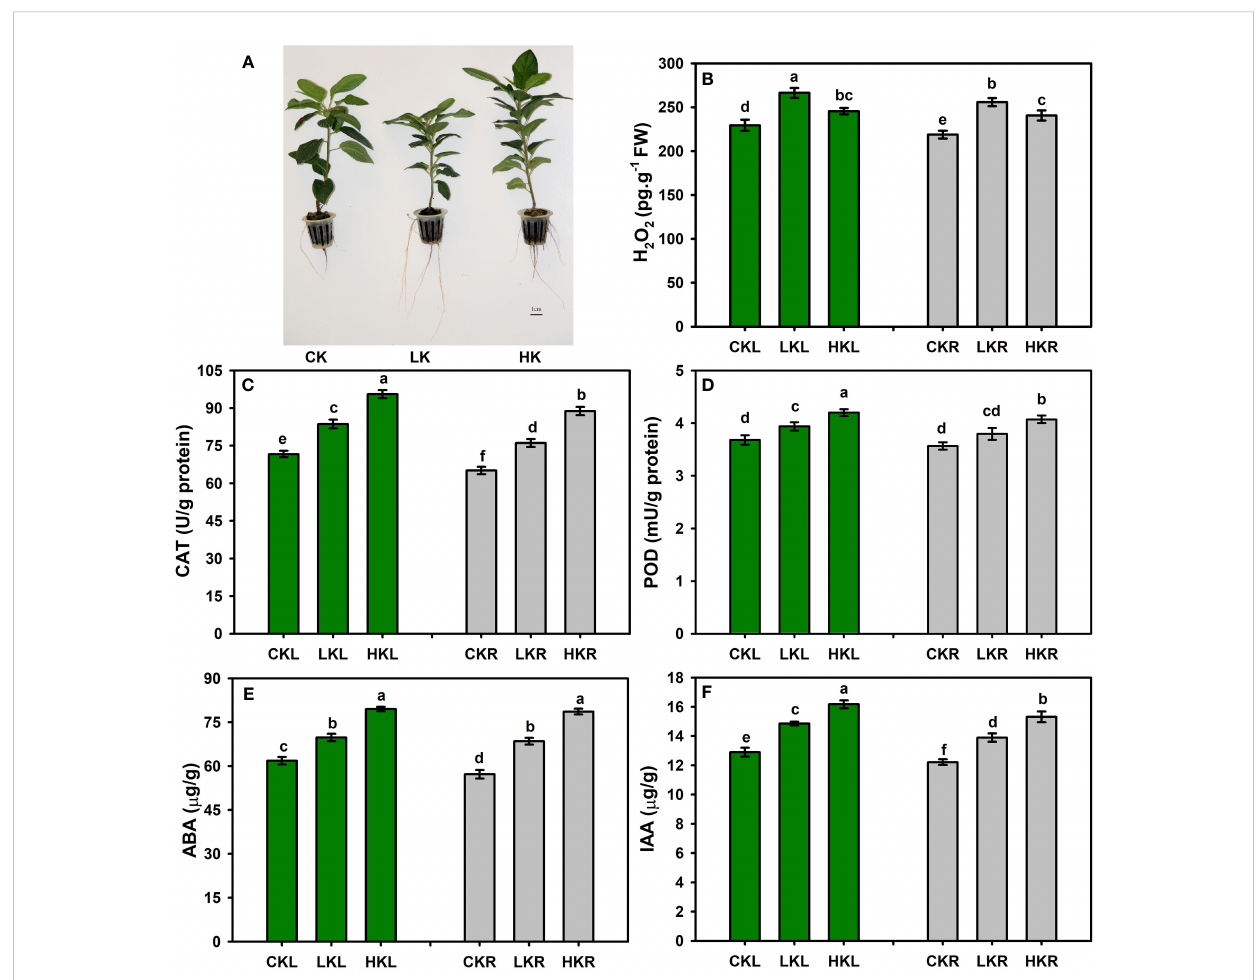
FIGURE 1 Measurement of H 2 O 2 , enzyme activities, and phytohormones in apple under different K treatments. (A) The phenotypic characteristics of apple. (B) The content of H 2 O 2 . The activities of CAT (C) and POD (D) . The contents of ABA (E) and IAA (F) . Different letters indicate signi fi cant differences according to Tukey ’ s multiple-range tests (p < 0.05).